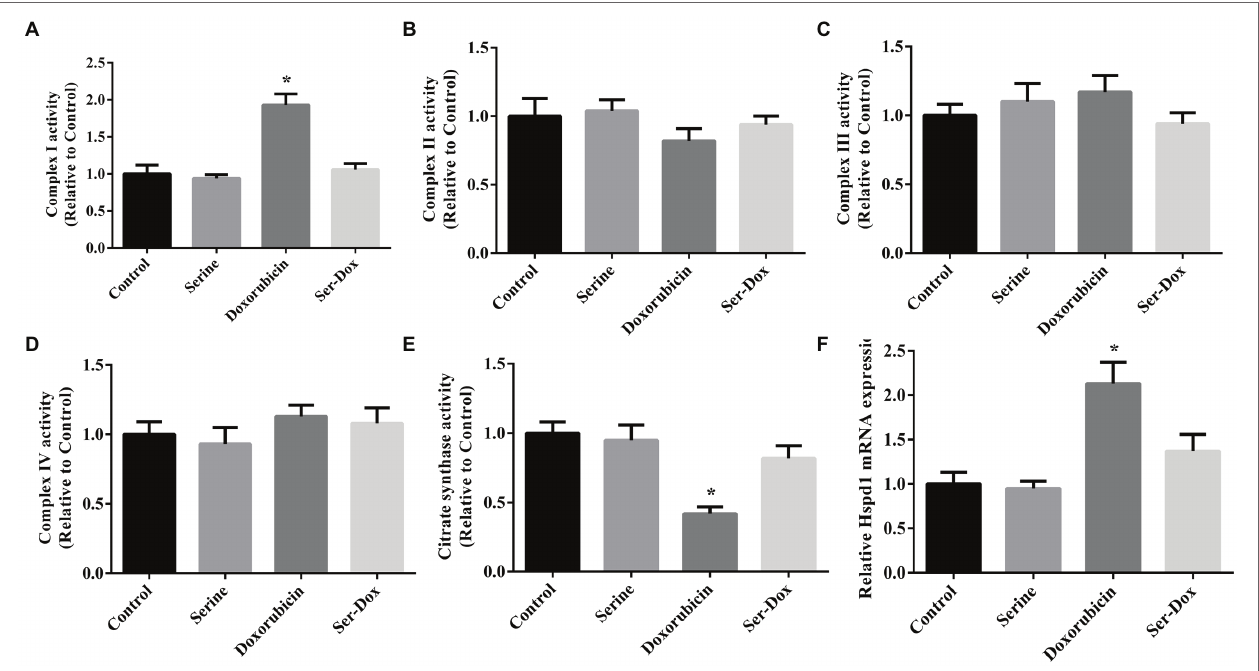
FIGURE 2 | Mitochondrial respiratory complex in the skeletal muscles of mice. Activity of complex I (A) , complex II (B) , complex III (C) , complex IV (D) , citrate synthase (E) , and mRNA expression of Hspd1 (F) in the skeletal muscles. Values are expressed as LSmean plus pooled SEM, n = 8. *Mean values were significantly different among groups ( p < 0.05). Hspd1, heat shock protein